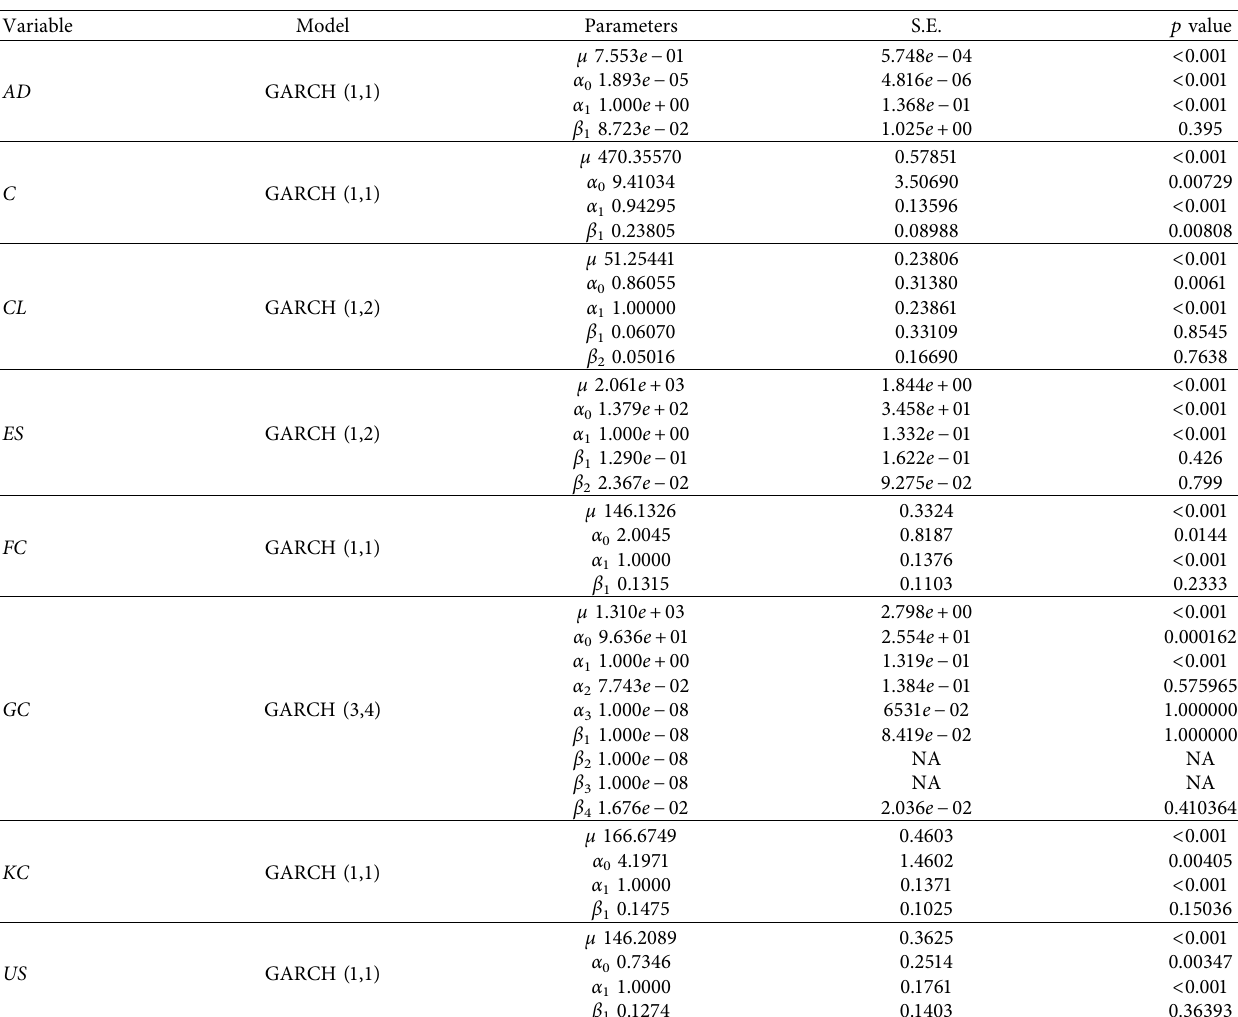
Table 9: Parameter estimation of GARCH